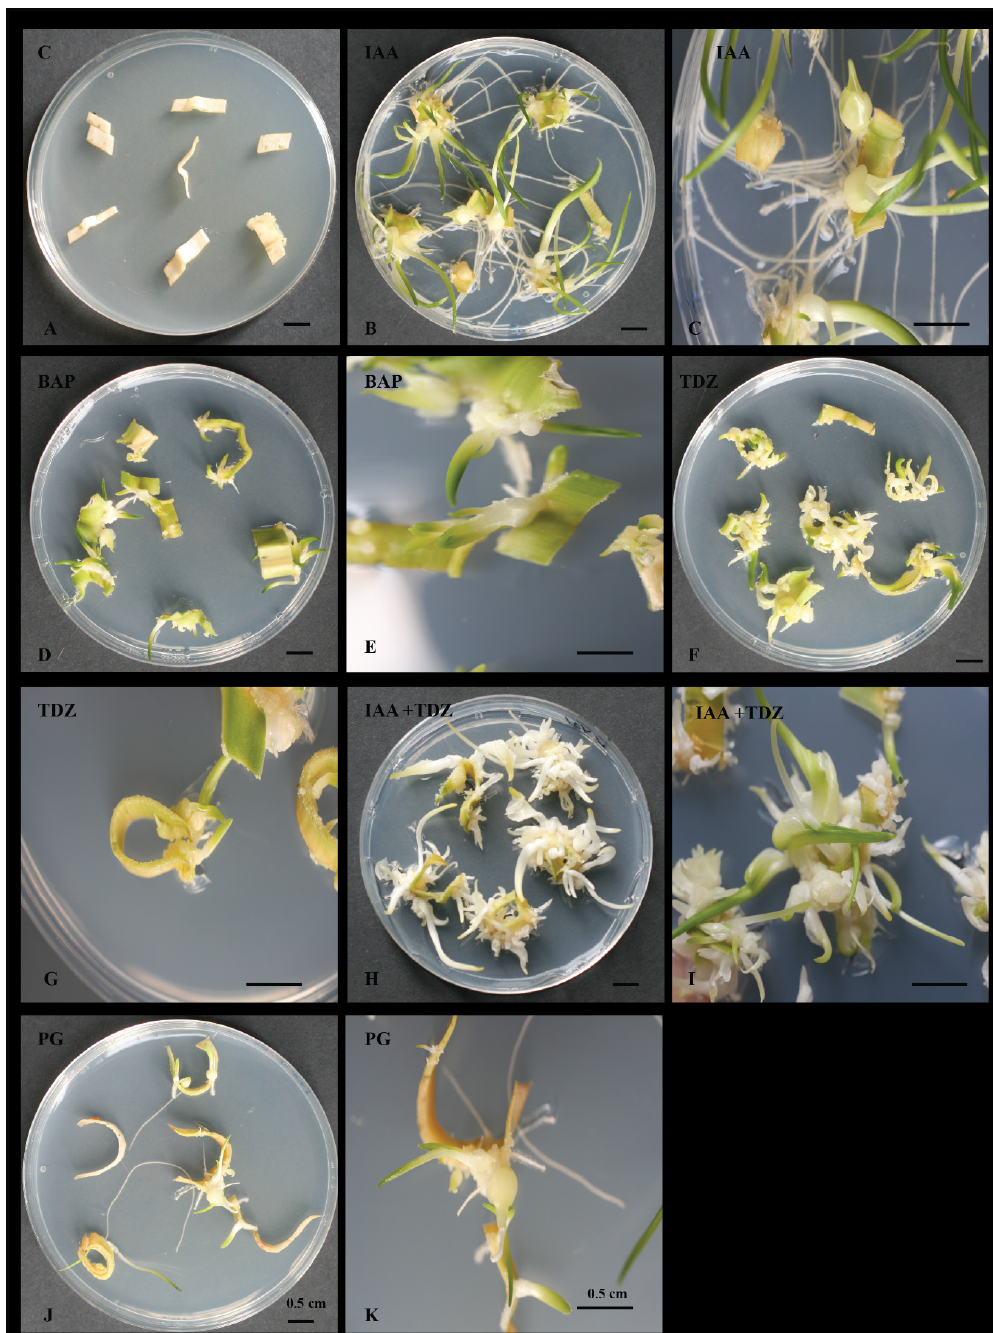
Figure 1. Regeneration properties of different hormones on Ornithogalum dubium explants: In ( A ), control fragments show complete bleaching. In ( B , C ), the effects of indole-3-acetic acid (IAA) are predominantly seen in extensive root formation. In ( D , E ), poorly organised clamps of calli are a response to benzylaminopurine (BAP). In ( F , G ), larger clamps and microbulb formation characterise the effect of TDZ supplementation. In ( H , I ), larger clamps with well-developed shoots respond to the combination of IAA + TDZ. In ( J , K ), shoots, microbulbs and roots are seen as a response to, PG (Phloroglucinol) application. All hormones were at the same concentration (1.5 mg/L). PG concentration was 4 mg/L.